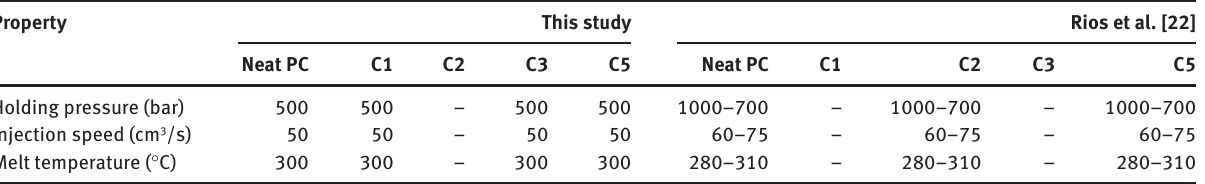
Table 10 Comparison of injection molding parameters with Rios’s study [22].